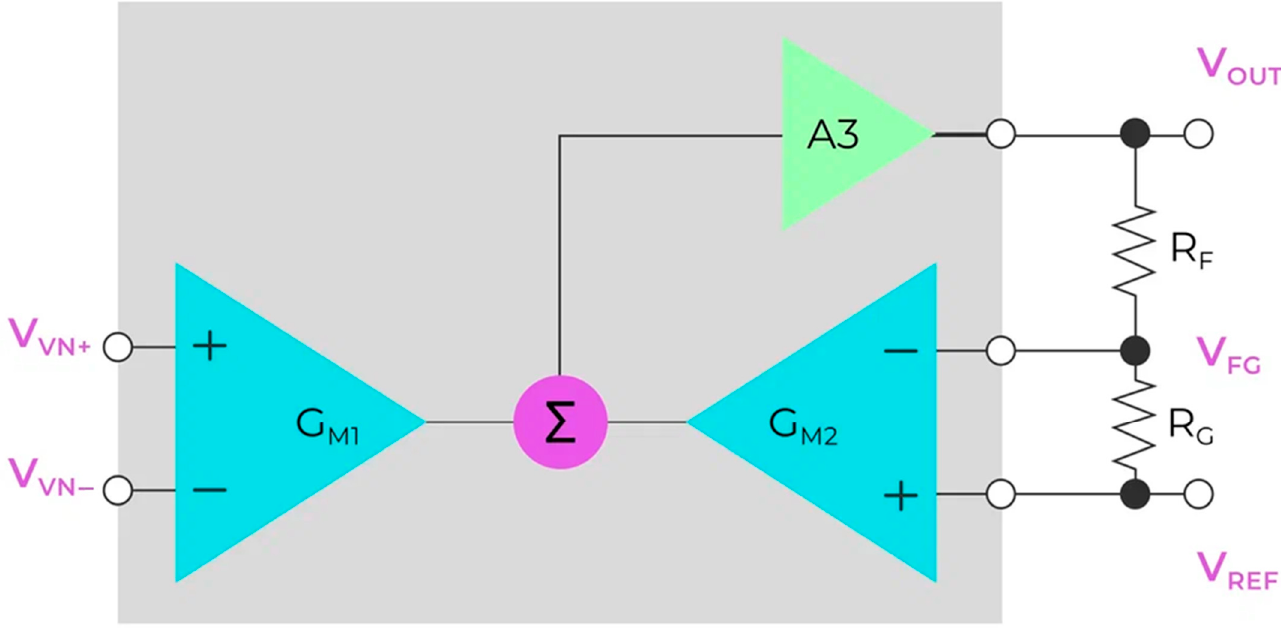
Figure 13. Input stage of AD8232 on matched transconductance amplifiers.